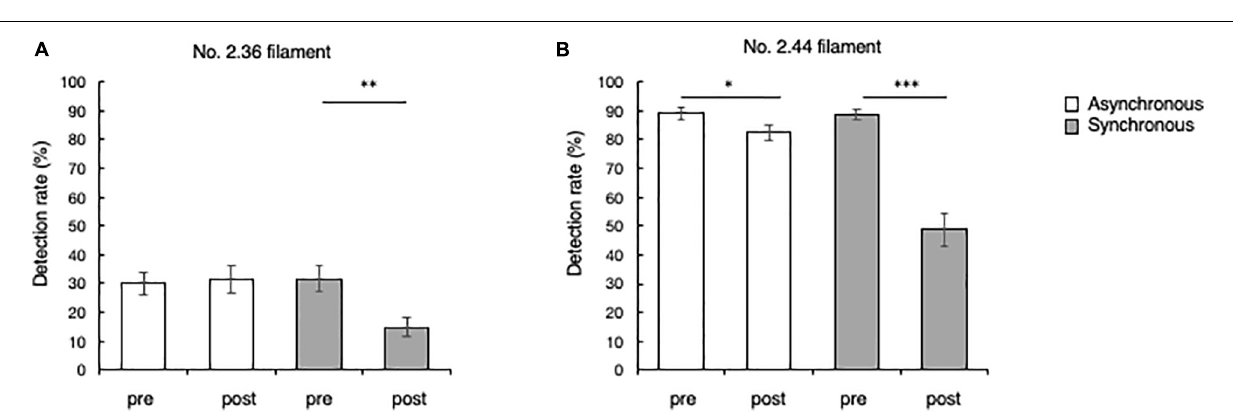
FIGURE 5 | Tactile sensitivity before and after the RHI. (A) The detection rates of the No. 2.36 filament in the synchronous and asynchronous conditions. (B) The detection rates of the No. 2.44 filament in the synchronous and asynchronous conditions. Pre indicates results before the illusion operation, and post indicates results after the illusion operation. ∗ p < 0.05; ∗∗ p < 0.005; ∗∗∗ p < 0.0005; error bars ± 1